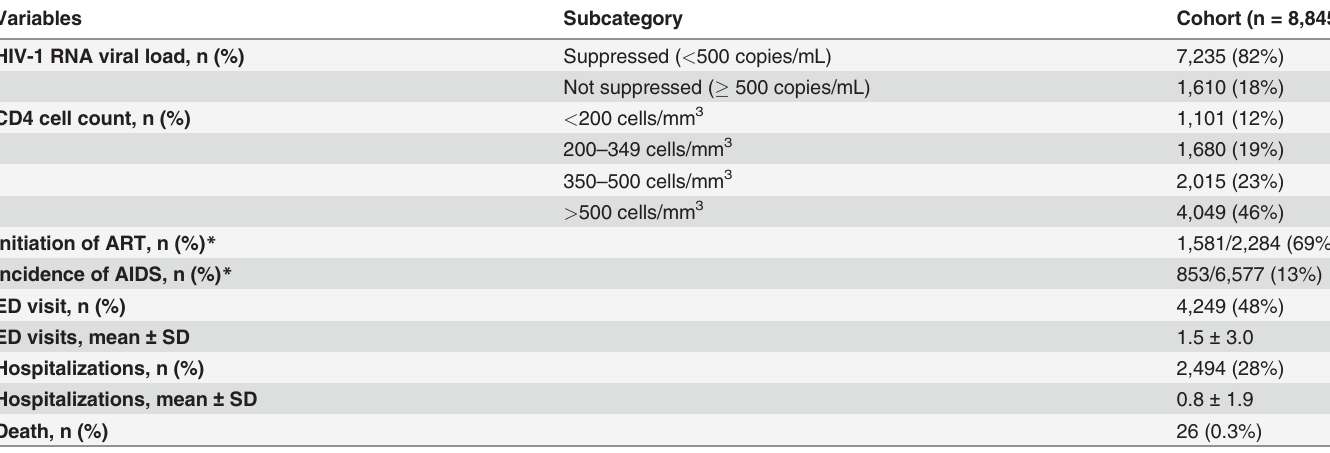
Table 3. Patient outcomes at 24 months.